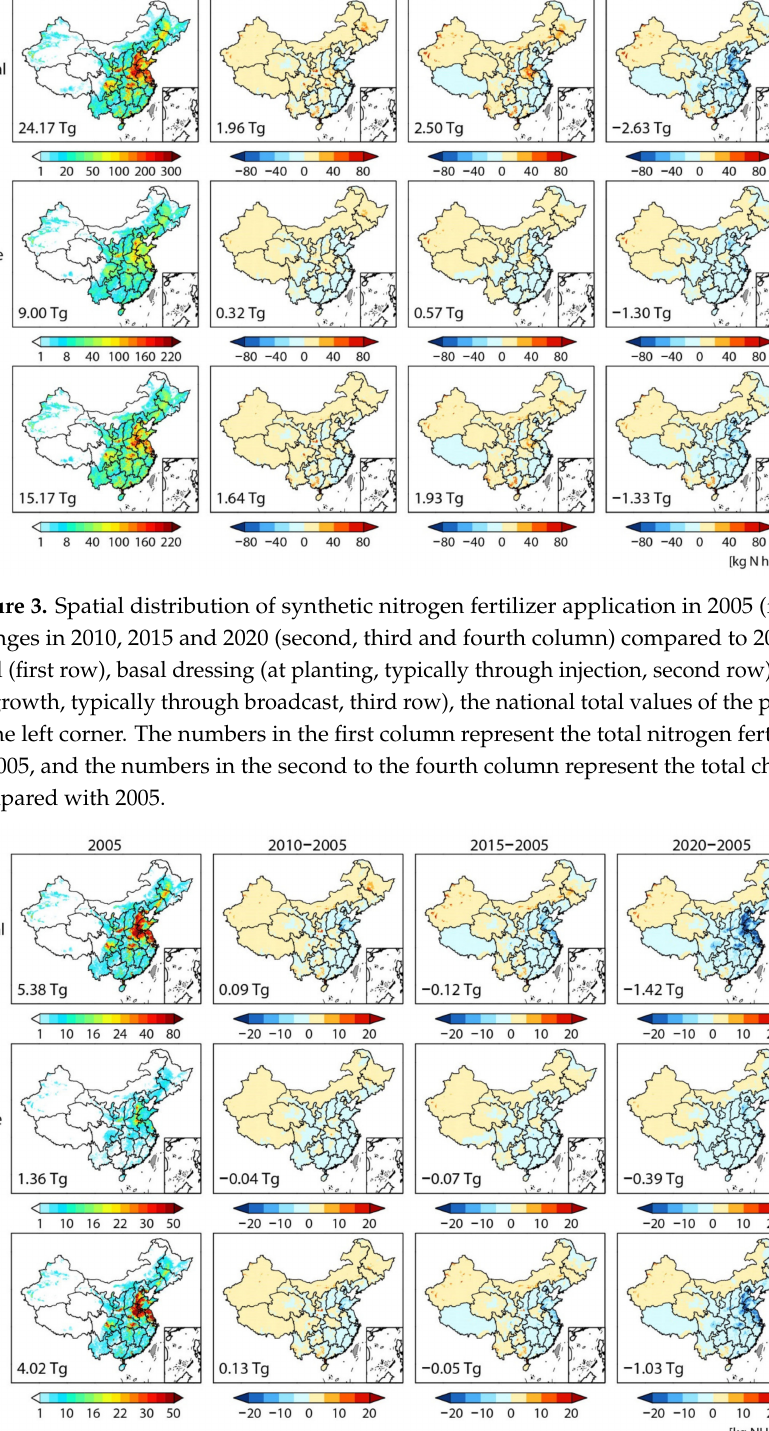
Figure 4. Spatial distribution of NH 3 emissions from synthetic nitrogen fertilizer application in 2005 (first column) and changes in 2010, 2015 and 2020 (second, third and fourth column) compared to 2005 over China in total (first row), basal dressing (at planting, typically through injection, second row) and top dressing (at growth, typically through broadcast, third row), the national total values of the plot are embedded in the left corner. The numbers in the first column represent the total NH 3 emissions from nitrogen fertilizer application in 2005, and the numbers in the second to the fourth column represent the total change in that year compared with